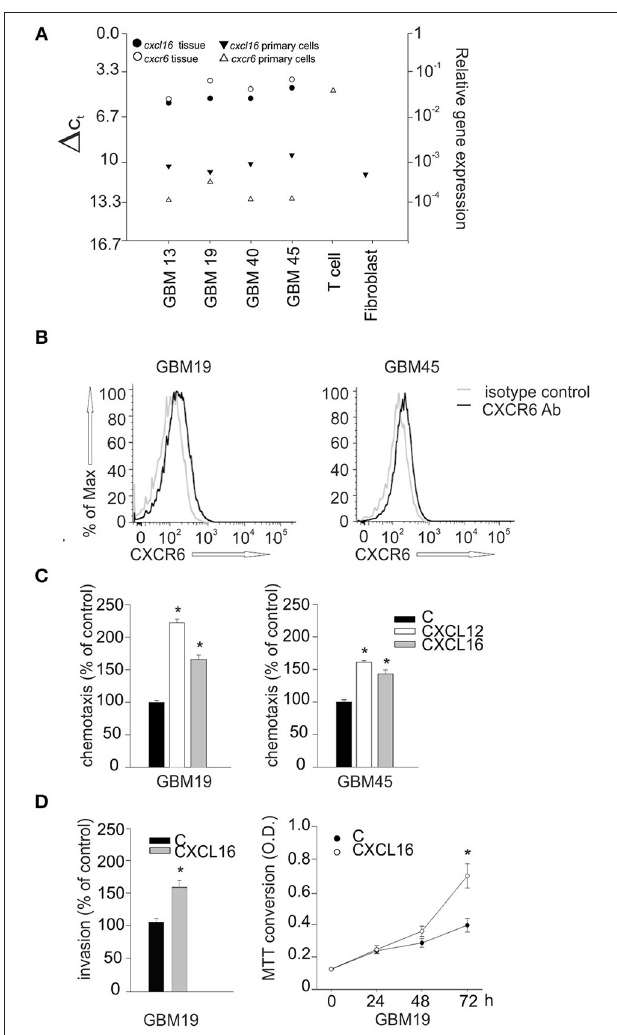
FIGURE 6 | Biological effects of CXCL16/CXCR6 axis on primary human glioblastoma cells. (A) cxcl16 and cxcr6 mRNAs expression in human GBM tissues (black and white circles), in human primary GBM cells derived from the same tissues and in human primary T cells and fibroblasts (black and white triangles) determined by RT-qPCR; (B) CXCR6 surface expression on primary GBM19 and GBM45 as evaluated by flow cytometry. Black and gray lines represent CXCR6 staining and isotype control, respectively; (C) Chemotaxis assay of human primary glioblastoma cells: GBM19 and GBM45, toward CXCL16 (10nM, 4h), CXCL12 (50nM, 4h) and vehicle (C). Data are expressed as percentage of cell migration vs. control; (D) Left panel, matrigel invasion assay on human GBM19, toward CXCL16 (10nm, 24h) and vehicle (C). Data are expressed as percentage of cell invasion vs. control ( n = 3, p < 0.05, Student’s t -test); right panel, proliferation assay of GBM19 upon stimulation with CXCL16 (10nM) at different time points (0, 24, 48, and 72h), data are expressed as MTT conversion optical density. Statistical analysis: Data are expressed as the mean ( ± s.e.m.) (C) n = 4, * p < 0.05, one-way ANOVA followed by Holm–Sidak post-hoc test; (D) left panel n = 3, * p < 0.05, Student’s t -test; right panel n = 3 in five replicates, * p < 0.05, Student’s t -test.